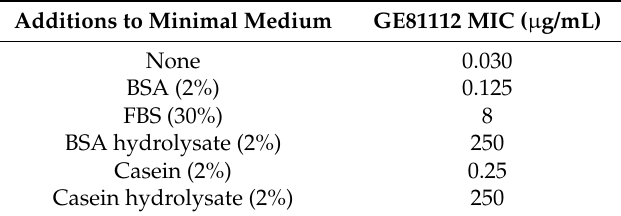
Table 2. Effect of proteins and protein hydrolysates on the microbiological activity (MIC) of